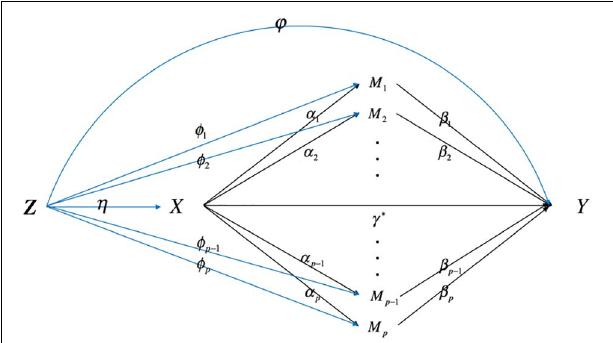
FIGURE 1 | The directed acyclic graph describes high-dimensional mediation with confounders affecting the relation among exposure, mediator, and